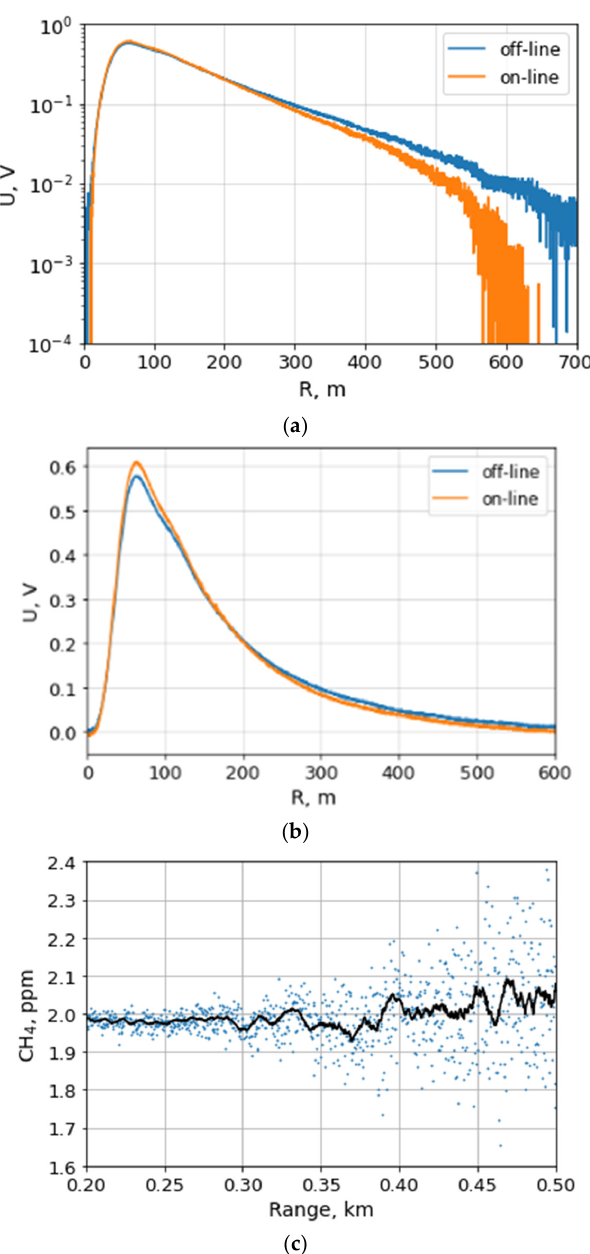
Figure 12. Lidar signals (U, V) at methane sounding informative wavelengths in ( a ) logarithmic form, ( b ) linear form; ( c ) average methane content retrieved from lidar signals.